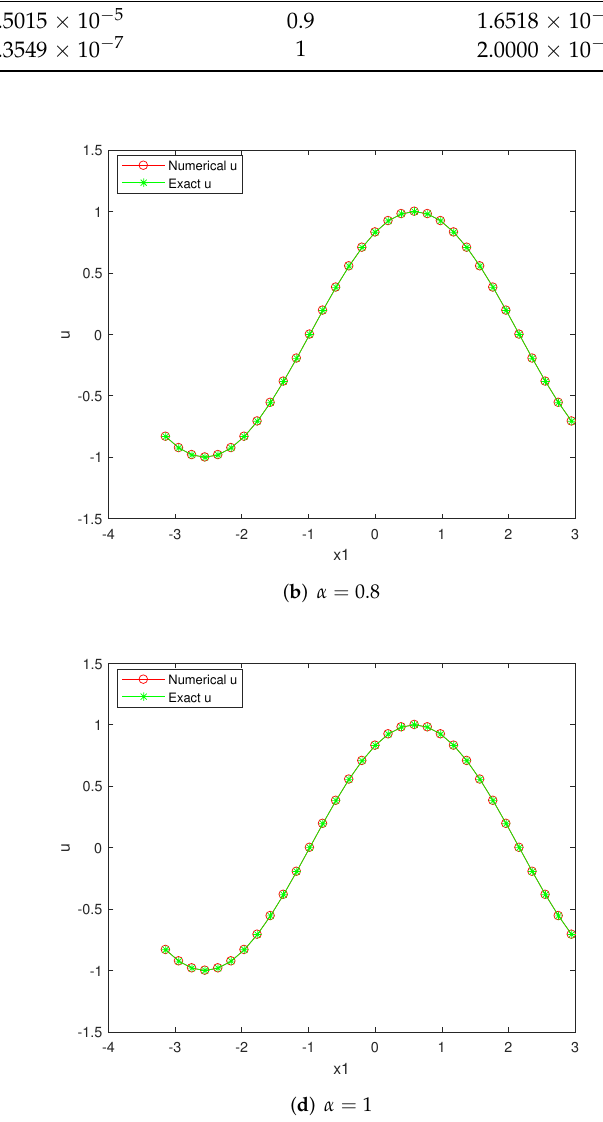
Figure 4. Example 2. Comparison of the numerical solutions and the exact solutions in Equation (86) at the end time for different fractional order α with x 2 = 1/24, y 1 = 1/12, y 2 =